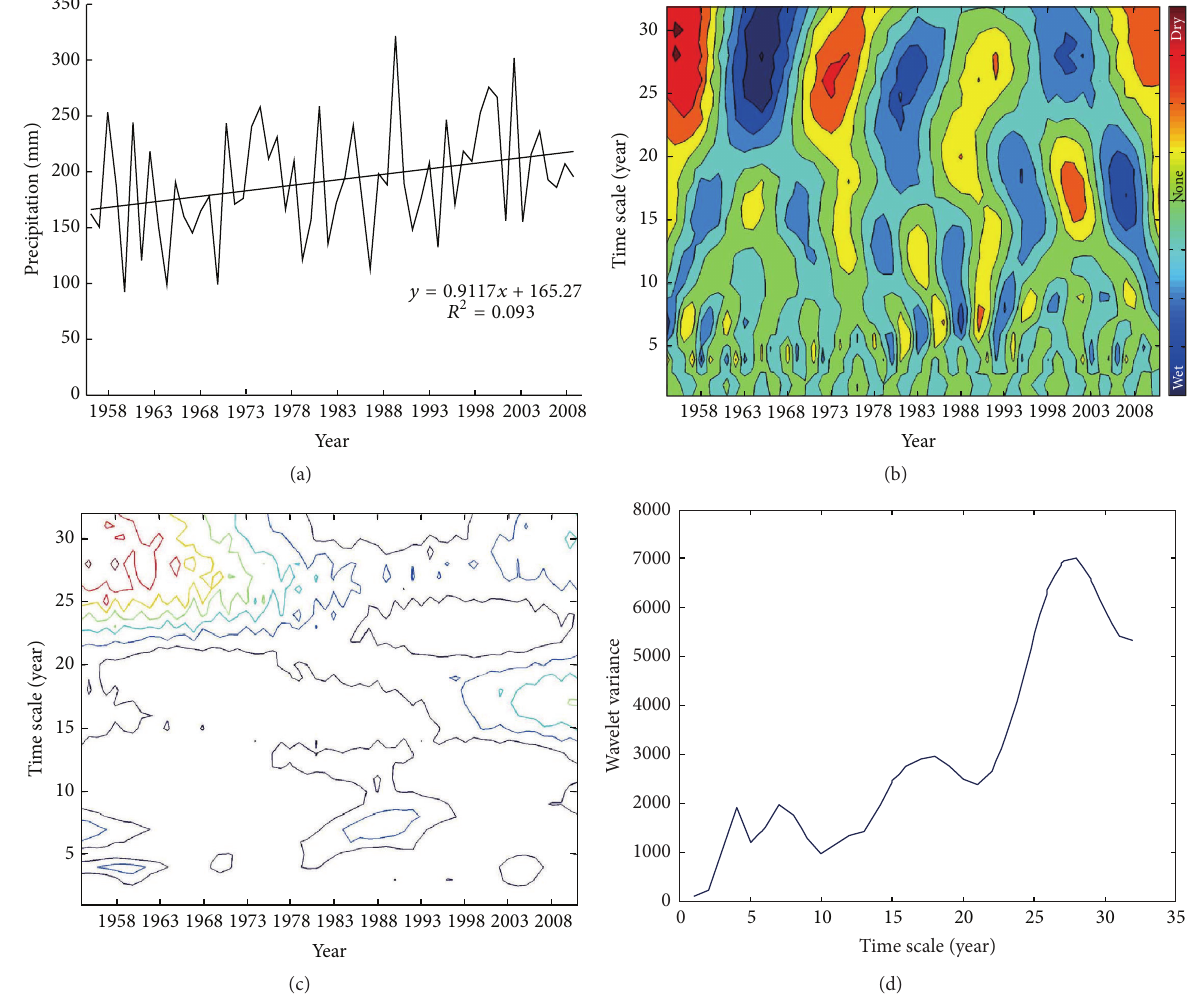
Figure 2: (a) Spring precipitation interannual change of Yunnan. (b) Spring precipitation wavelet transform of Yunnan. (c) Spring precipita- tion wavelet coefficients contour of Yunnan. (d) Spring precipitation wavelet variance of